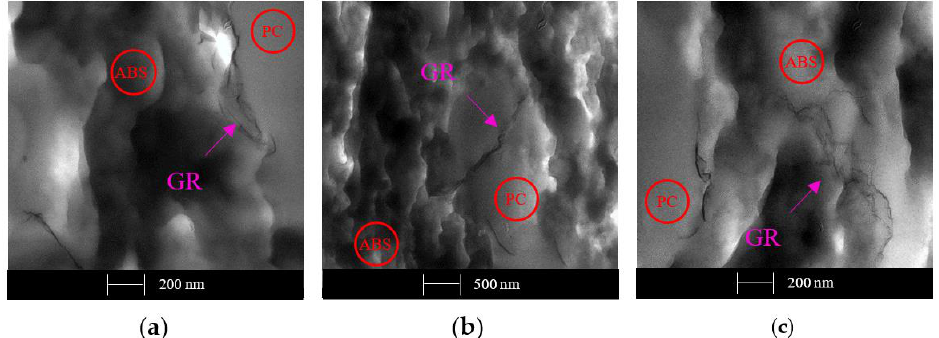
Figure 11. TEM micrographs of a sample with 1 wt. % of GR obtained by the melt extrusion method. Different locations of GR sheets on the PC/ABS blend domains: ( a ) GR located on the surface between PC and ABS domains; ( b ) GR located on PC moiety; and ( c ) GR located on ABS moiety.